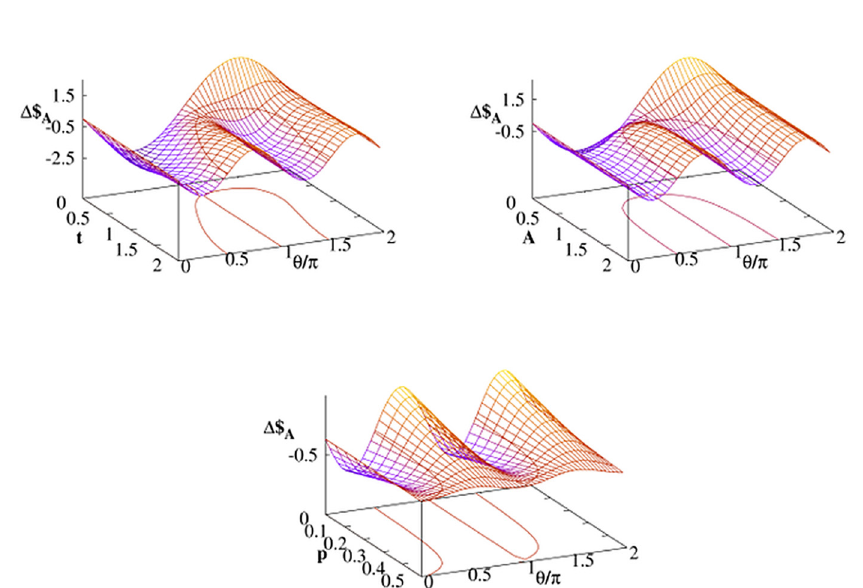
Fig 5. Payoff differences Eq (29) as a function of A calculated at time t = 2 for a mixed Alice – Bob strategy profile ( V c , V c U ) with V c = V /2+ F /2 and the quantum strategy Eq (12) with U = U ( π /2,0, π /2). The thermal Davies environment (with G = 1) influences only Alice ’ s qubit. We set A = 0 and p = 0 in panels where these parameters are fixed.